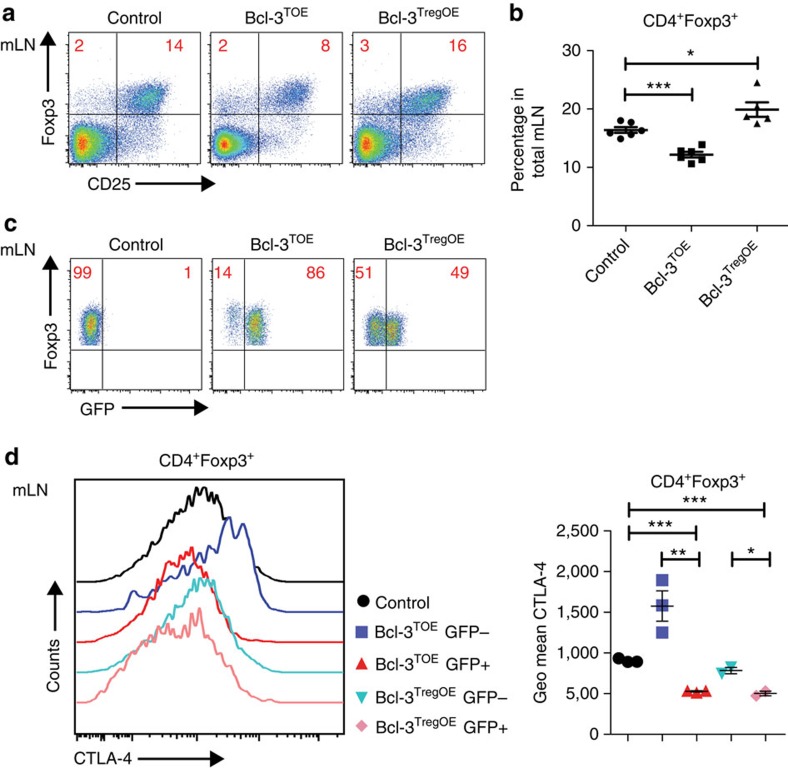
Bcl-3 inhibits Treg development intrinsically.(a) Flow cytometric analysis of mLNs from Bcl-3TOE, Bcl-3TregOE and littermate control mice using indicated antibodies. Numbers in plots/quadrants indicate percentage. Cells are gated on live CD4+ T cells. Data shown are representative of at least three independent experiments with n=3. (b) Percentage of CD4+Foxp3+ T cells in total mLN from Bcl-3TOE, Bcl-3TregOE and littermate control mice. Graphs show mean±s.e.m. *P<0.05 and ***P<0.001 using unpaired Student's t-test. n=5–6 mice per group. (c) Cells from mLN of Bcl-3TOE, Bcl-3TregOE and littermate control mice were analysed for Foxp3 and GFP expression by flow cytometry. Numbers in plots/quadrants indicate percentage of CD4+Foxp3+GFP− and CD4+Foxp3+GFP+ cells. Cells are gated on live CD4+Foxp3+ T cells. Data shown are representative of at least three independent experiments with n=3 (d) Flow cytometric analysis of mLN from Bcl-3TOE, Bcl-3TregOE and littermate control mice gated either on CD4+Foxp3+GFP+ or CD4+Foxp3+GFP+ cells. Histogramm (left) displays CTLA-4 expression and graph (right) shows the Geometric Mean Fluoreszence Intensity of CTLA-4 expression for the indicated groups with n=3 mice per group. Bcl-3OE mice without Cre were used as littermate controls.